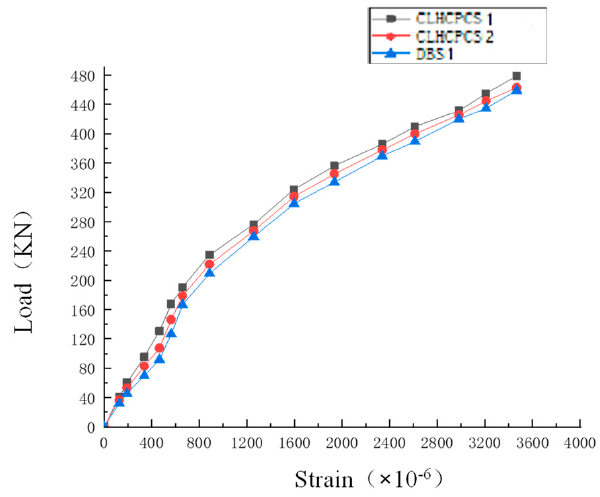
Figure 21. Load − strain curve diagram of longitudinal reinforcement bar of the composite slab.